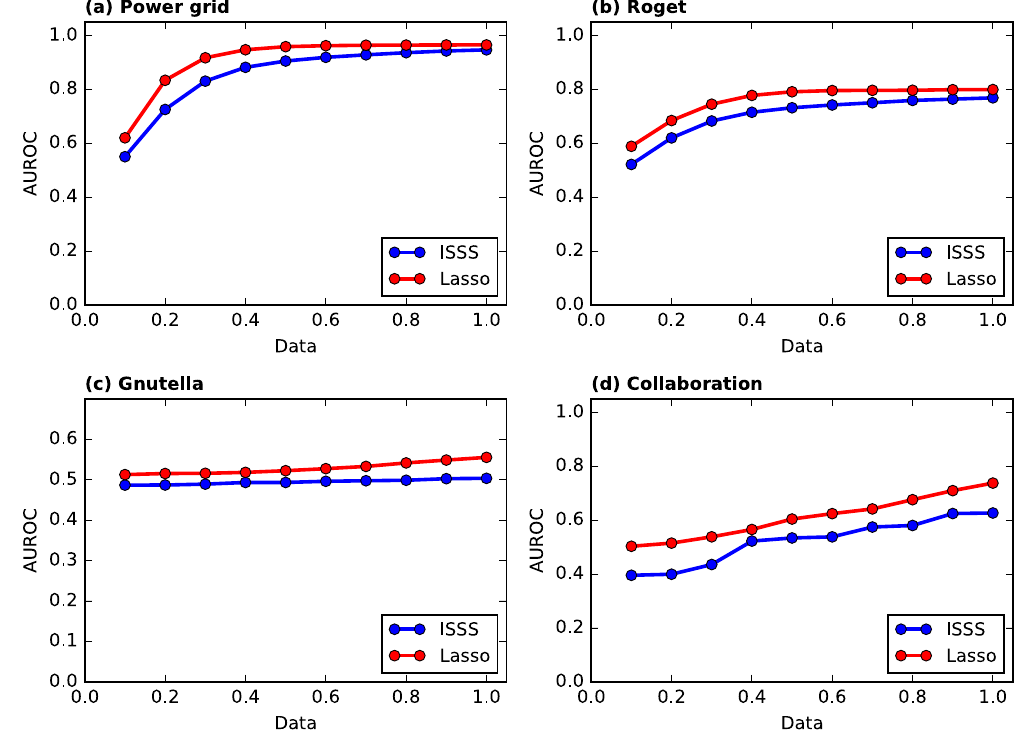
Figure 4. The performance of ISSS and Lasso on power grid, roget, Gnutella peer-to-peer file sharing network and collaboration network in computational geometry. The performance of ISSS and Lasso ON Gnutella network are not good enough. The reason is that we need more training data to infer the network, i.e., Data = M/N = 2, where M is the time instances and N is the number of vertices in the